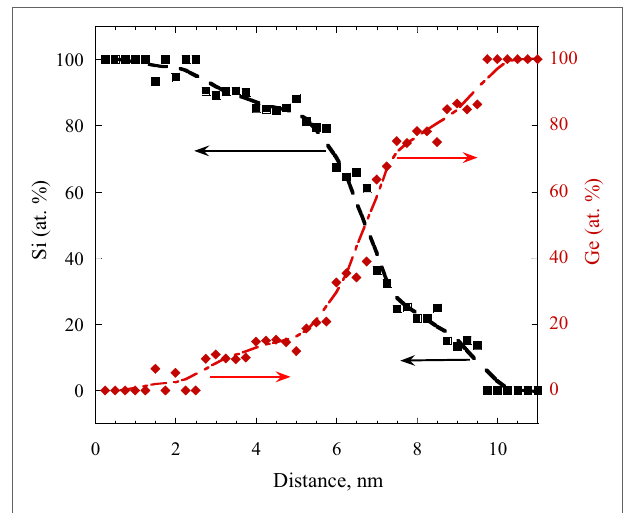
FiGURe 6 | Compositional analysis of the Nw along the growth direction showing a spontaneously formed SiGe transition alloy layer at the SiGe interface (wang et al., 2015)